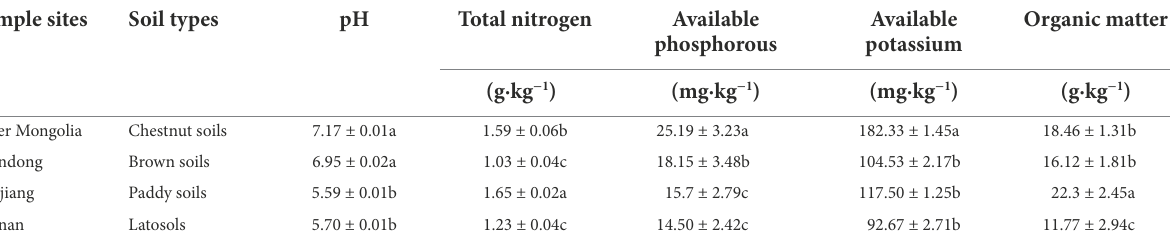
TABLE 1 Physicochemical properties of sampled soils.